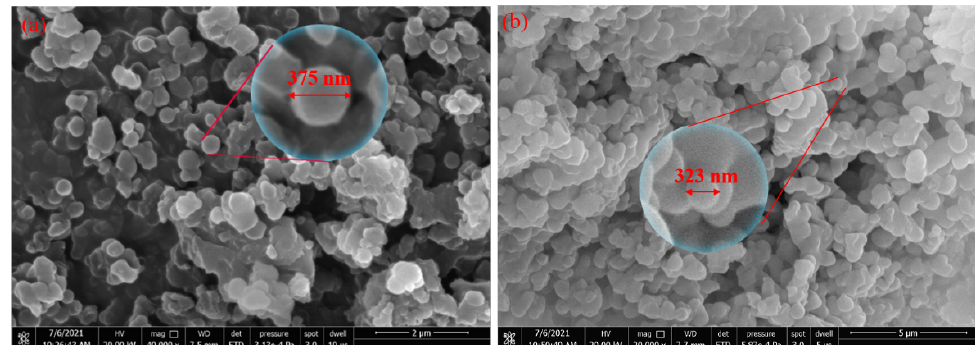
Figure 2. SEM imgaes of CPBI 2 ( a ) and CPBI 4 ( b ).